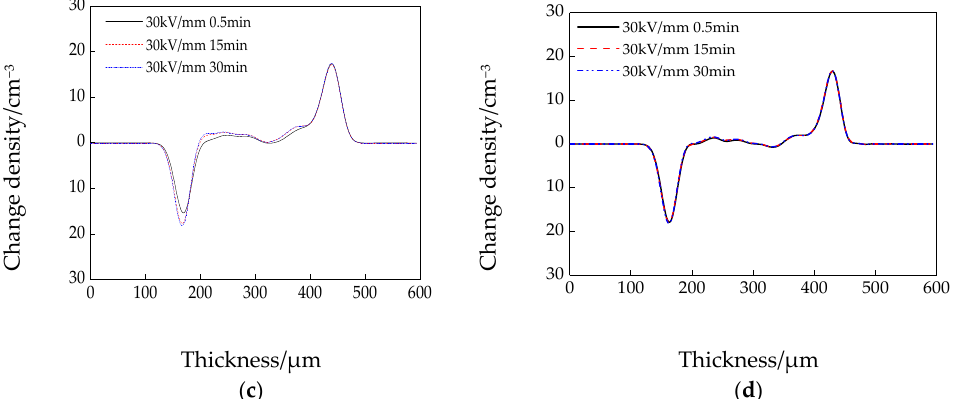
Figure 4. Space charge distribution in the four samples under the electric field: ( a ) LDPE, ( b ) N3, ( c ) M3, ( d ) N3M2.